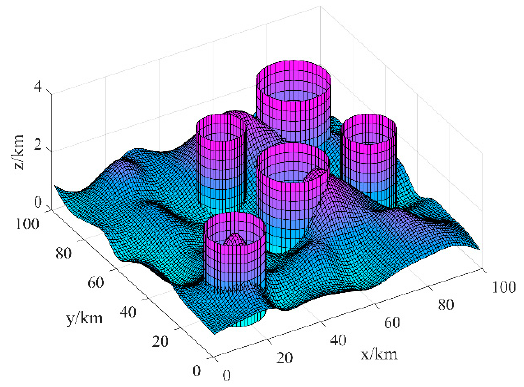
Figure 1. Battlefield environment.